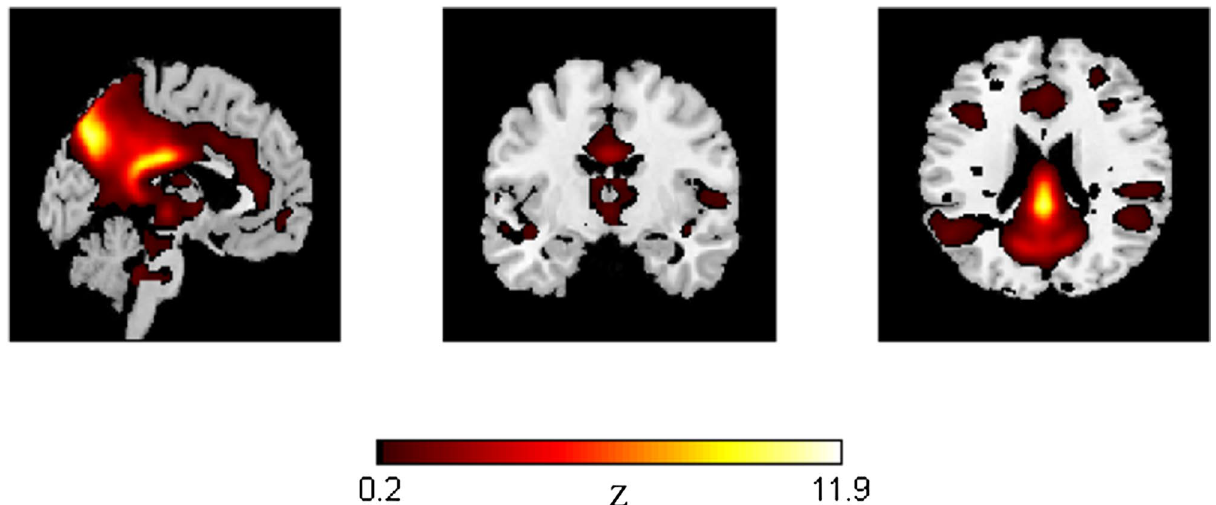
Figure 2. Mean group statistical map of the spatial component of the ventral DMN given by ICA analysis in GIFT toolbox.